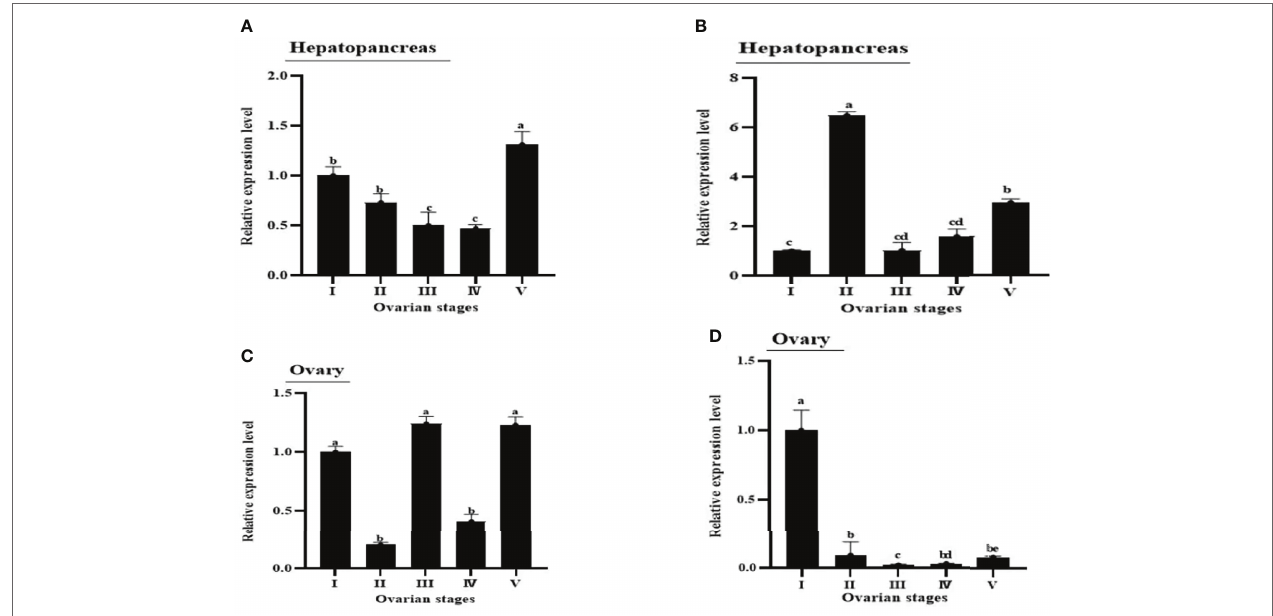
FIGURE 5 | Expression patterns of MrNP1 and MrNP2 in (A, B) hepatopancreas and (C, D) ovary in female M. rosenbergii in different reproductive stages (i.e., I, II, III, IV, V). Data shown are means of relative expression levels ± SD. Different letters indicate significant differences at P < 0.05 computed with ANOVA and the Tukey–Kramer